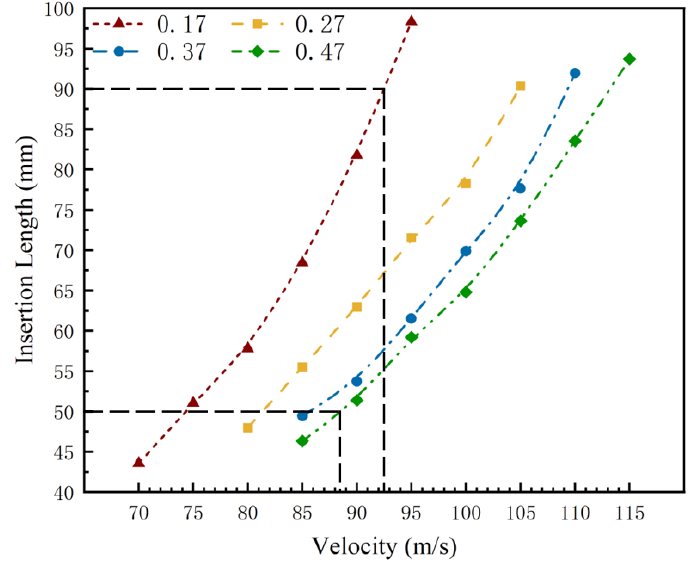
Figure 14. Embedding length and velocity relationship under variable friction